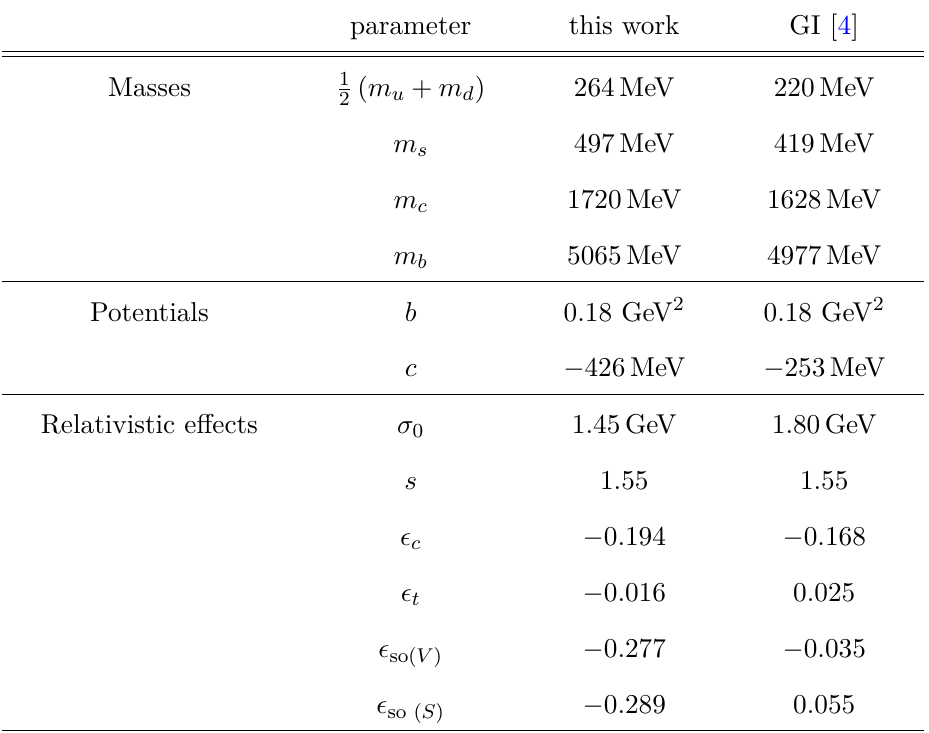
Table 1 . The free parameters in the potential quark